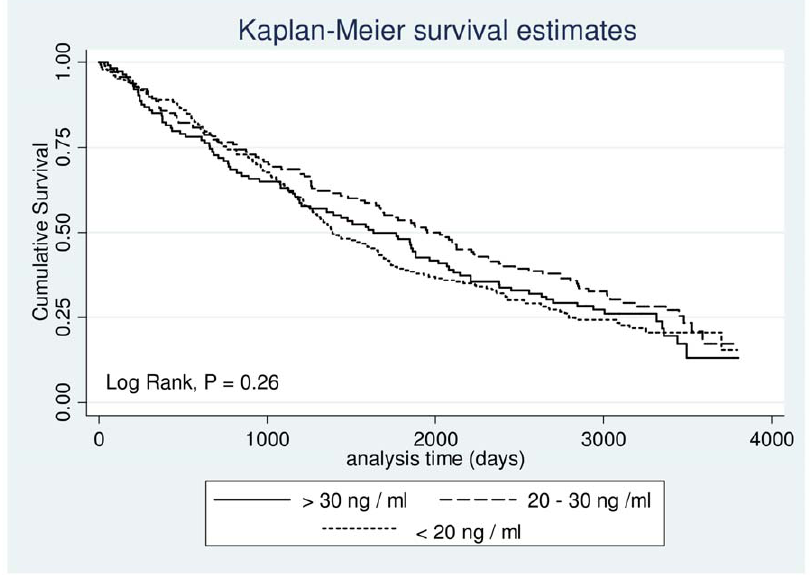
Figure 1. Three-year survival according to conventional levels of serum 25-OHD deficiency and insufficiency. Differences between groups were examined using a log-rank test. Result is displayed as a p value in the lower left corner.